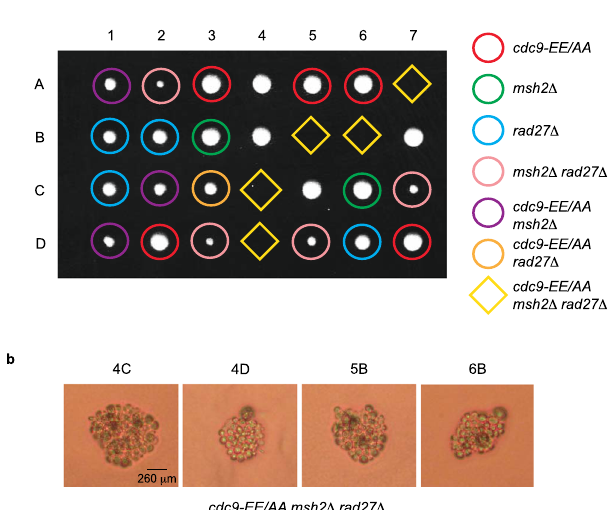
Fig. 3 High- fi delity DNA ligation is required in the absence of both MSH2 and RAD27 . a A diploid yeast strain heterozygous for cdc9-EE/AA , msh2 Δ , and rad27 Δ was sporulated, dissected, and the haploid spore colonies were genotyped by appropriate marker selection. 1 – 7 are tetrad dissections and A – D are haploid spore colonies. Plates were imaged after 3 days growth on YPDA at 30 °C. b Microscopic images of the indicated microcolonies taken after 5 days of growth reveals that the cdc9-EE/AA msh2 Δ rad27 Δ haploid derivatives sporulated but only divided a fi nite number of times. Thirteen dissections were performed using three independently derived diploid strains and similar results were obtained each